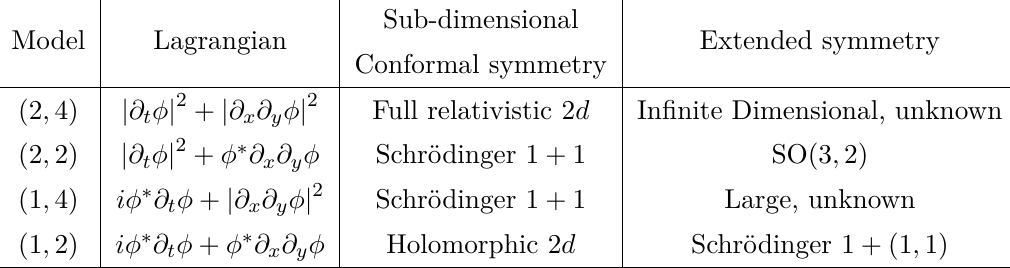
Table 1 . The four models we consider, and a summary of their sub-dimensional and extended space time